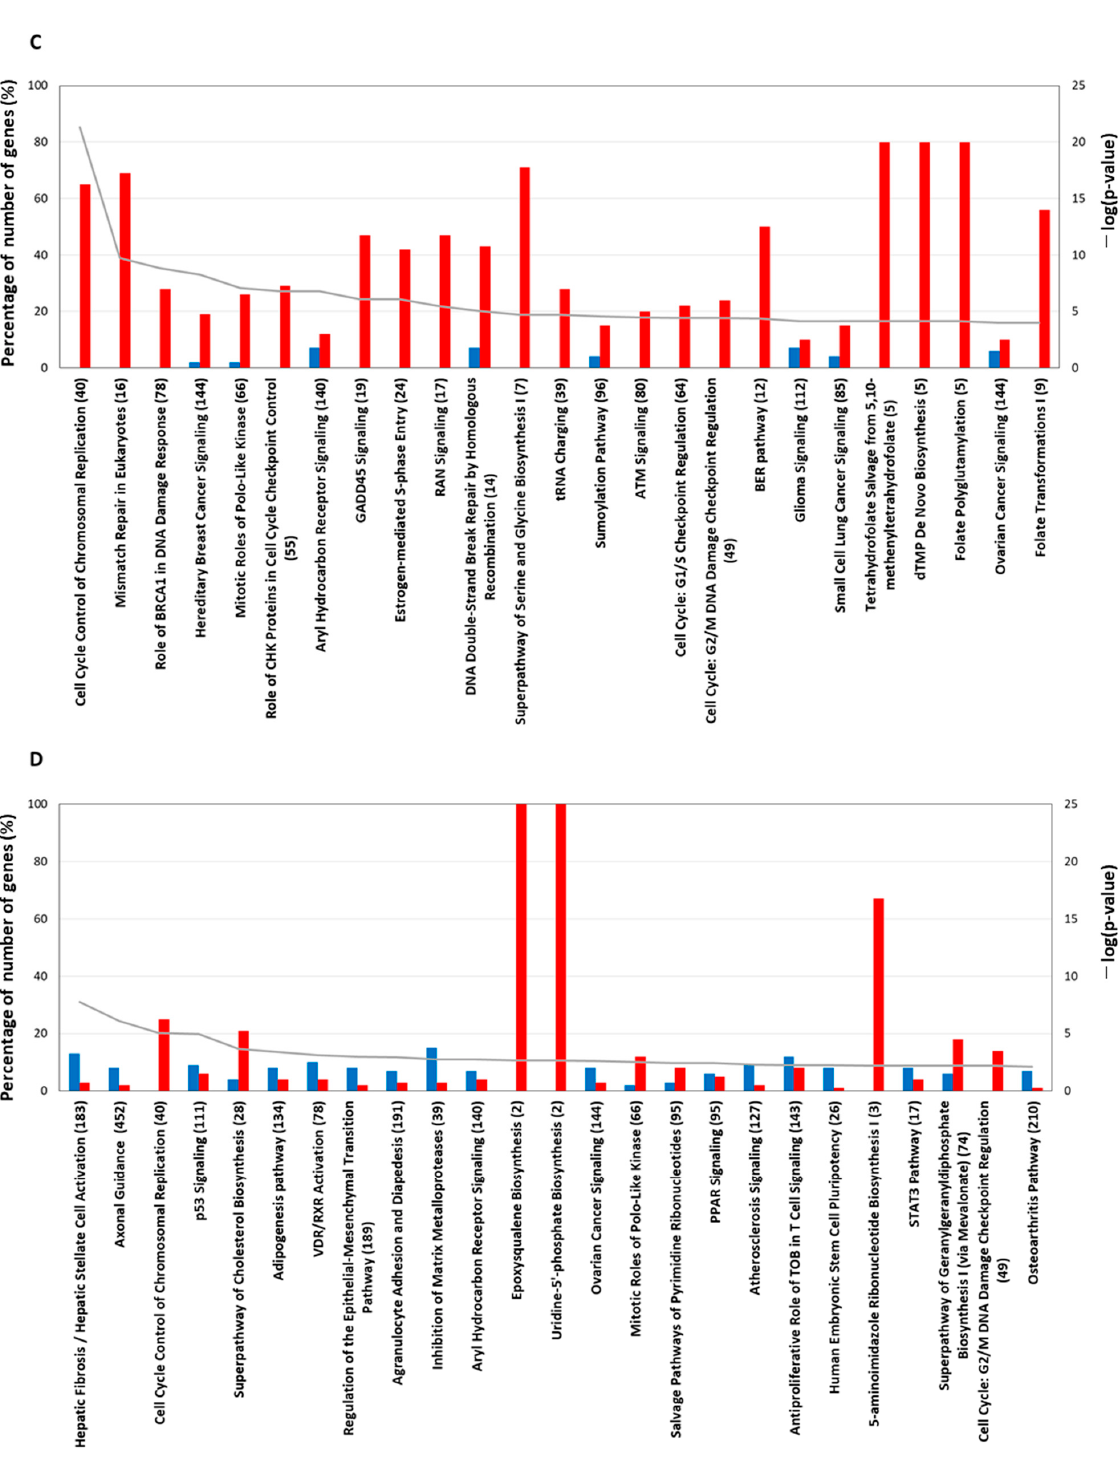
Figure 5. The top-25 canonical pathways. TPA treatment for ( A ) 1 h and ( B ) 6 h. The line graph shows a list of genes whose expression increased or decreased at each treatment time and the − log value ( p -value) obtained by testing a list of genes of the canonical pathway via Fisher’s exact test. The bar graph shows the rate (%) of the number of genes that were up-regulated (red) and the number of genes that were down-regulated (blue) when the number of genes in a known pathway was 100%. The top-25 canonical pathways (continued). TPA treatment for ( C ) 24 h and ( D ) 8 days. Other explanations are the same as for the graphs of the 1 h treatment and the 6 h treatment.